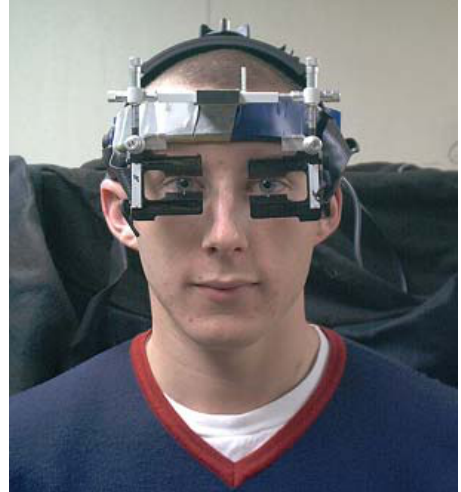
FIGURE 3 . Subject wearing helmet containing the binocular eye movement sensor unit. Eye movement sensor unit in each eye contains arrays of infrared emitters (upper black rectangular piece) and detectors (lower black rectangular piece). As the eye rotates, the amount of infrared reflection from the white part of the eye changes, which can be recorded as a voltage change.